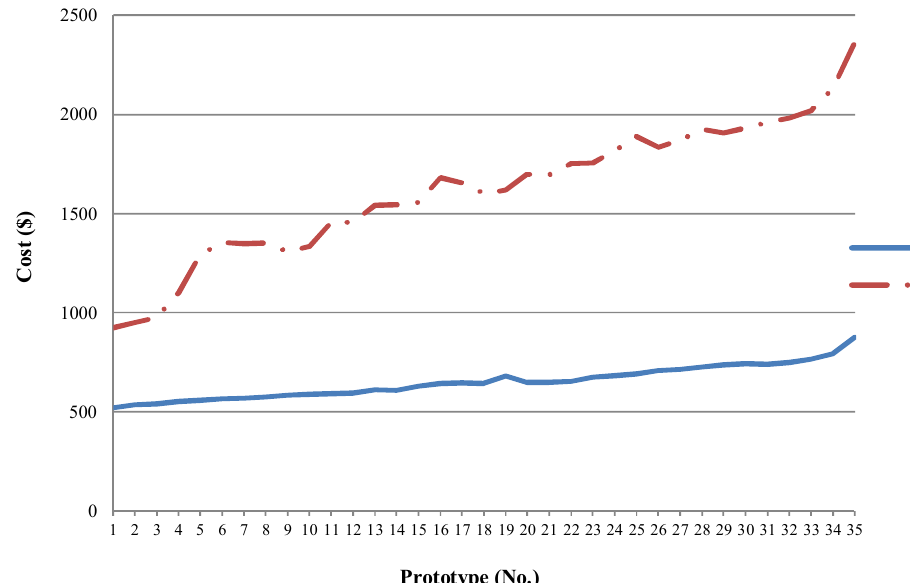
Fig. 10 . Comparing the costs for design, construction or simulation of hyper tracer robot prototypes based on V-model and W-model